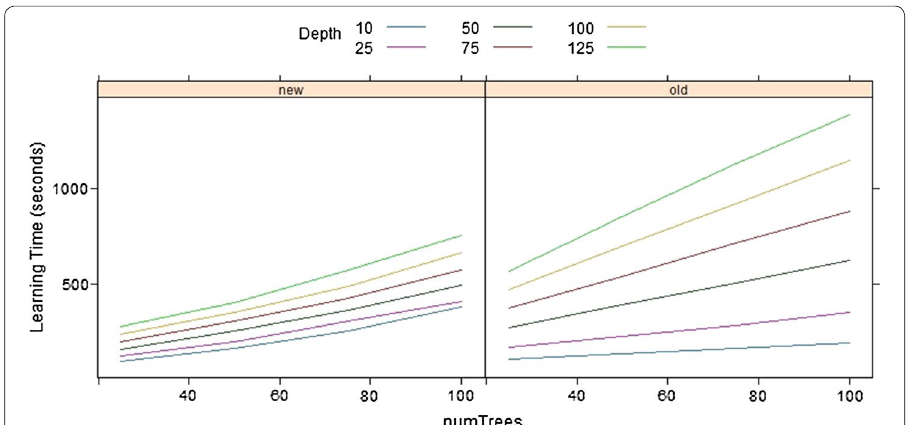
Fig. 9 Preliminary Learning runtime comparison for increasing Number of Trees (numTrees)